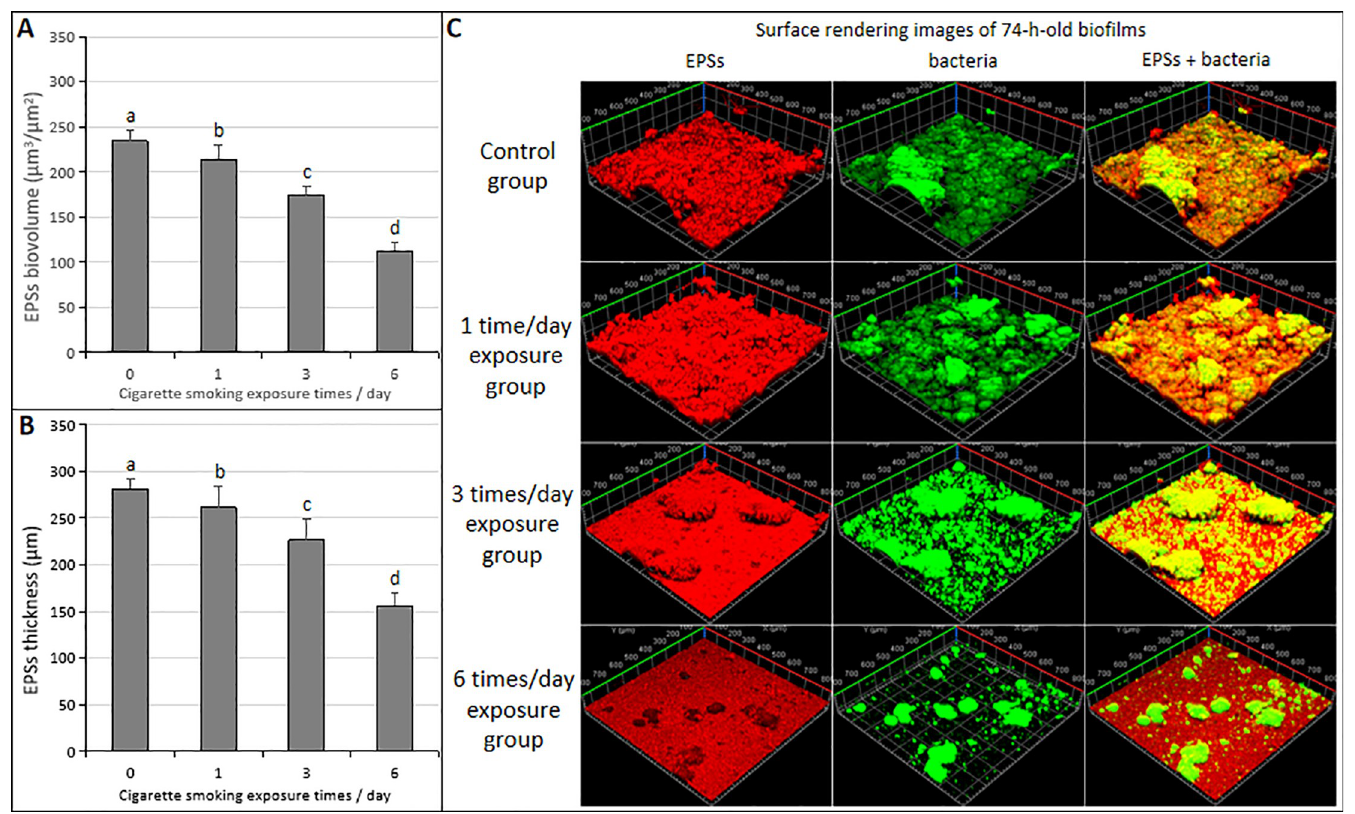
Fig 6. Change in CLSM of EPSs in the 74-h-old S . mutans UA159 biofilms exposure with CS. ( A ) EPSs biovolume. ( B ) EPSs thickness. ( C ) Representative confocal images. Significantly different from each other ( p < 0.05).